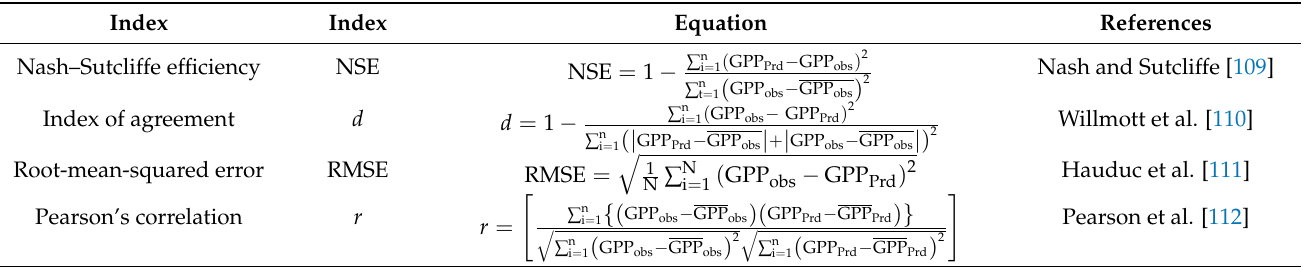
Figure A1. Land-cover data from the SHARE dataset [50] . Table A1. Details of indicators with the statistical equations to assess the performance of the modeled GPP against the observed GPP in Yatir Forest